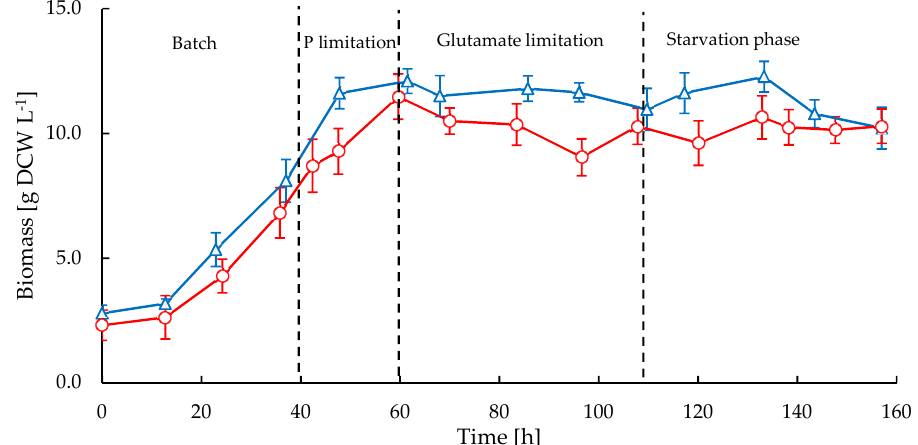
Figure 1. Time course of biomass in stirred tank bioreactor (STR, triangles) and CELL-tainer ® (CT, circles) in fed-batch cultivations of Streptomyces clavuligerus.